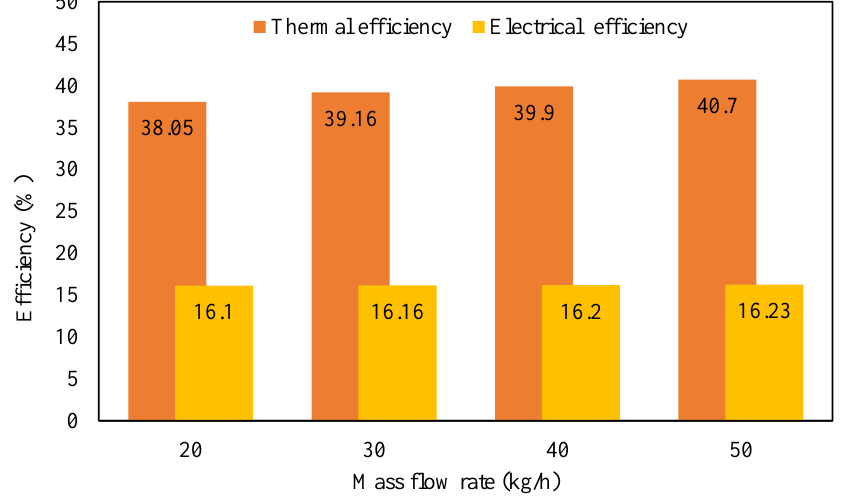
Fig. 10. Average thermal and electrical efficiencies of (glazed)PVT/(glazed)ST system at different mass flow